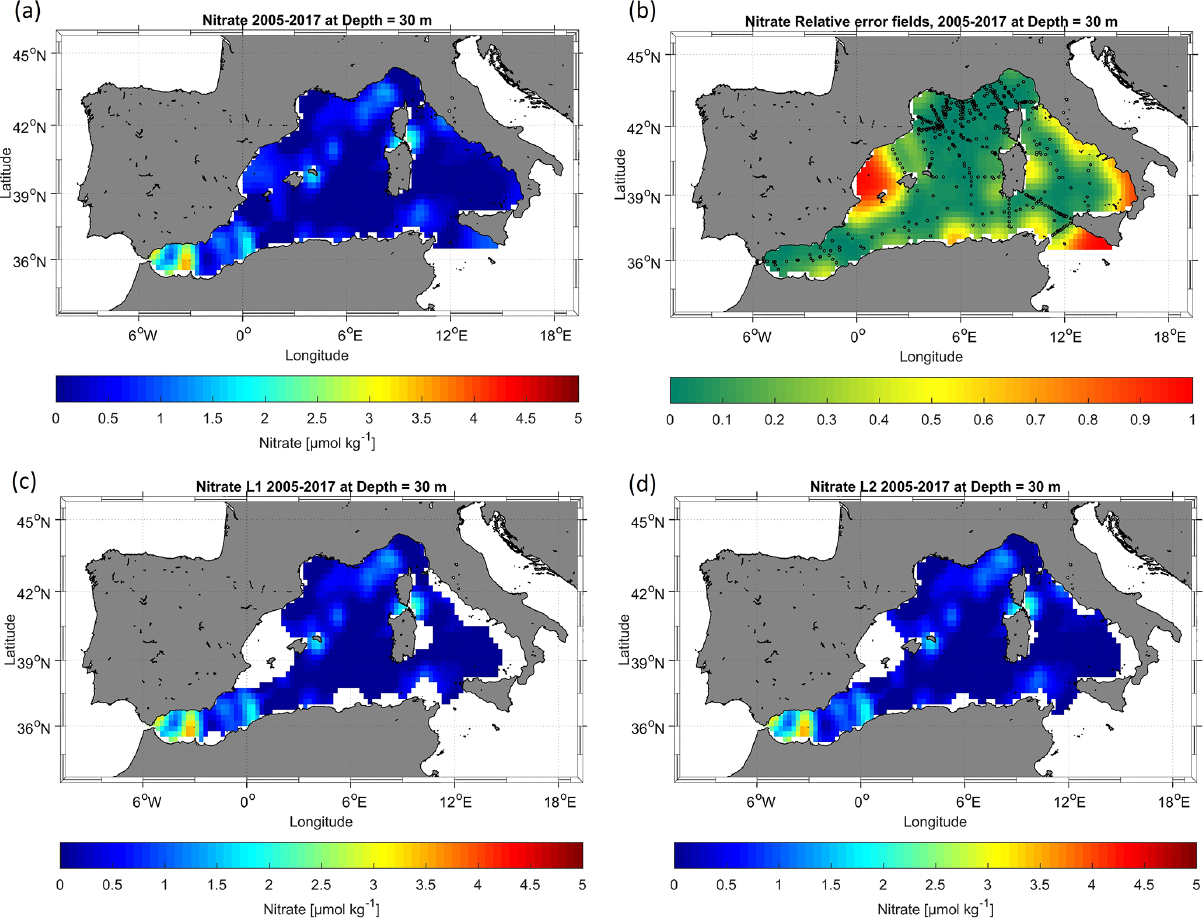
Figure 8. Example of nitrate analysis for the period 2005–2017: (a) unmasked analysis field, (b) relative error field distribution with the observation in black circles, (c) masked analysis fields masked using a relative error threshold of 0.3 and (d) masked analysis fields masked using a relative error threshold of